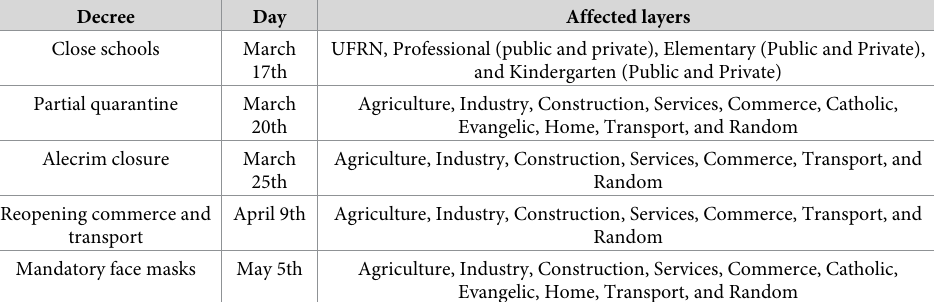
Table 4. Decrees affect simulation dynamics with variable impact on the different layers and sub-layers over the first wave pandemic. The first column represents the decree’s name. The second column is the implementation day. The third column displays the layers and sub-layers affected by the decree. The baseline simulation scenario defines the P contamination value relative to each